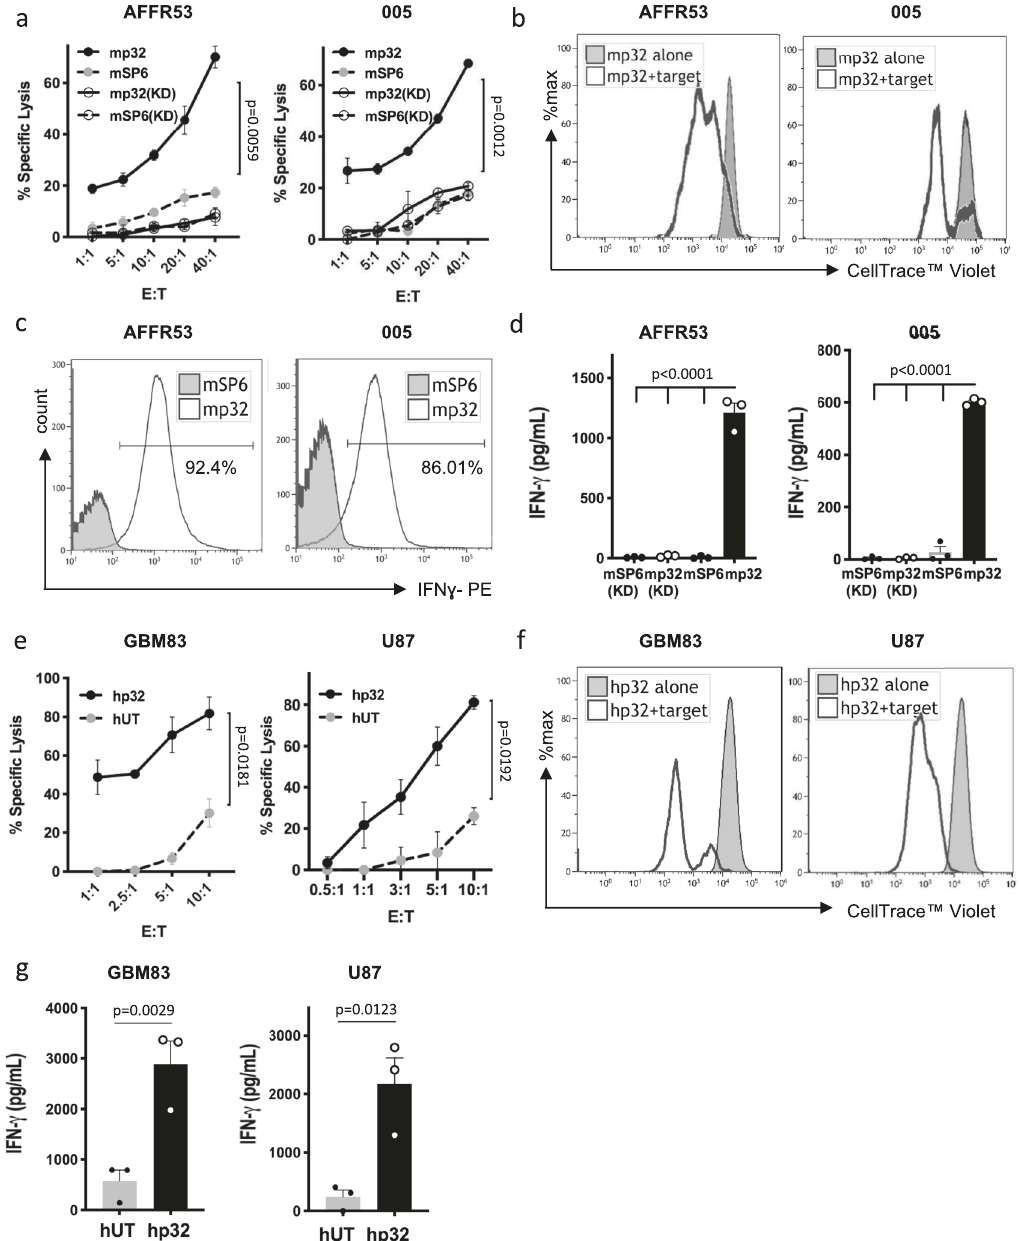
Fig. 3 Murine and human p32 CAR T cells speci fi cally target p32 expressing glioma cells. a Speci fi c cytotoxicity towards p32-positive and the corresponding p32 KD cells (knockdown; transduced with lentivirus expressing shRNA targeting p32) was measured by LDH activity in culture media. Target cells were co-cultured with either a non-relevant (mSP6) or p32 murine CAR T (mp32) cells for 6 h at the indicated E:T ratios. Data represent mean ± SEM. N = 3. One-way ANOVA, Tukey ’ s multiple comparisons test. P value shown in graph corresponds to the comparison of the mp32 vs mSP6. P < 0.004 for the remaining comparisons. b CellTracer TM Violet dilution assay of labeled p32 CAR T murine lymphocytes co-cultured with the indicated glioma cells for 3 days (E:T = 3:1). Labeled unstimulated p32 CAR T cells alone were used as control. Representative histogram is shown out of four independent experiments. c , d Transduced murine lymphocytes were incubated with the target cells (E:T = 2:1) for 24 h, and IFN- γ production was measured by FACS intracellular staining ( c ) and by ELISA ( d ). N = 3, representative histogram is shown. Dots in graph ( d ) show average for each independent experiment. Data are shown as mean ± SEM. Statistical signi fi cance was determined using one-way ANOVA test with multiple comparisons adjustment. e Human target glioma cells were co-cultured with control untransduced T cells (hUT) or CAR-p32 T cells (hp32) at the indicated E:T ratios. Eighteen hours later, the cytotoxic action of the human CAR T cells was measured by quantifying luciferase activity in tumor target cells. Data represent mean ± SEM. N = 5 for GBM and N = 4 for U87 independent experiments, two different human donors were used. Unpaired t test with Welch ’ s correction was used for statistical analysis. Two-tailed P value is shown. f CellTracer TM Violet dilution assay (representative histograms from three independent experiments with two different donors) and g IFN- γ secretion (ELISA; N = 3 independent experiments with two different donors) were also assessed using hUT and hp32 T cells following co-culture with the indicated human glioma cells. Data are shown as mean ± SEM. Unpaired t test was used. Two-tailed P value is shown. All source data are provided as a Source Data fi